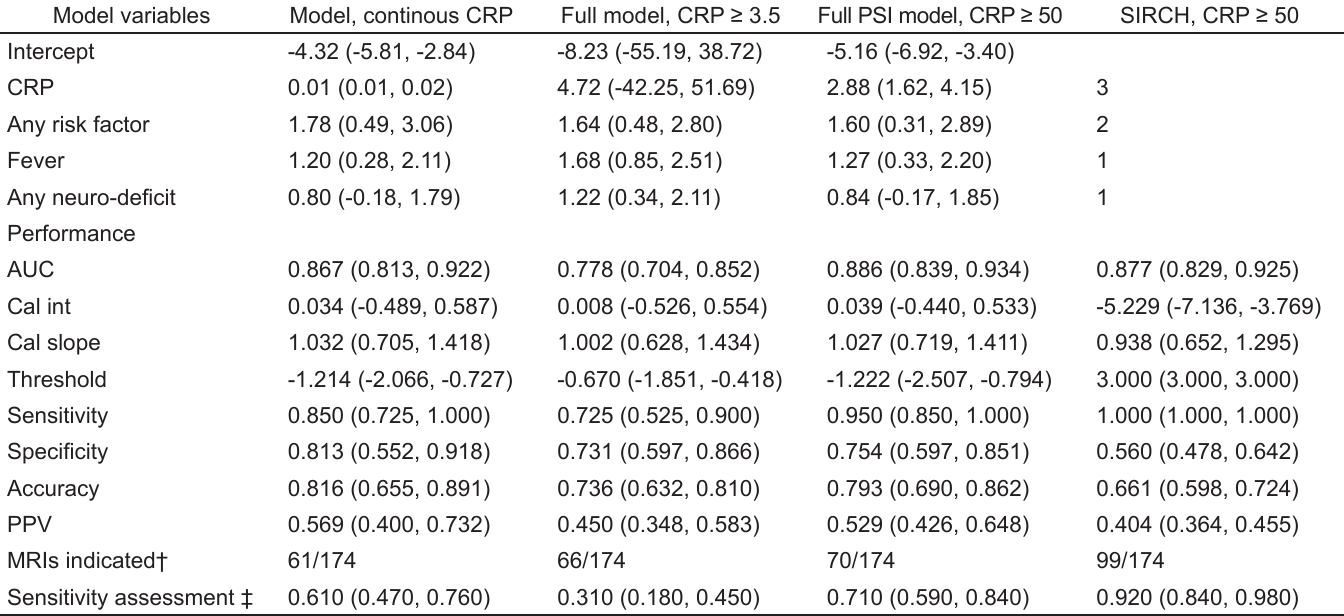
Table 2. Multivariable full prediction models and SIRCH